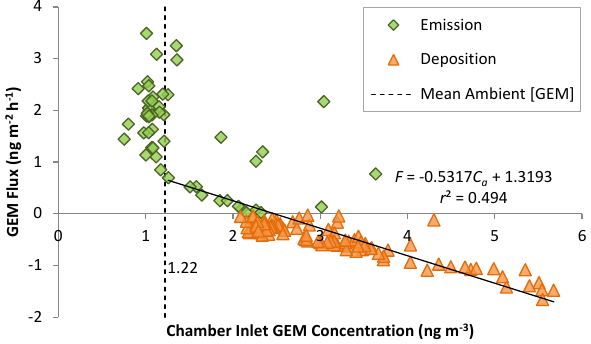
Fig. 5. GEM fluxes, and GEM concentrations at the chamber inlet, oo l s nd T taken over Site B3 during June study. Chamber inlet GEM concen- trations greater than the mean ambient taken at the beginning of the study were used to construct the linear least squares trend, where F = GEM flux and C a = GEM